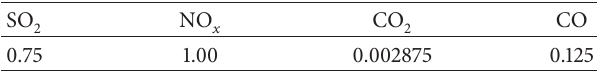
Table 2: Standard pollutant emission penalties ($/kg).